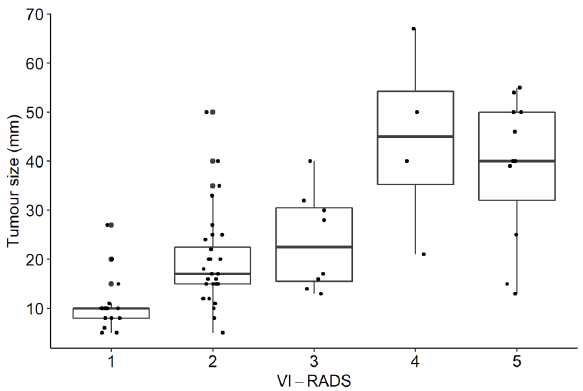
Fig. 2. Visualizing the relationship between tumour size (mm) and VI-RADS